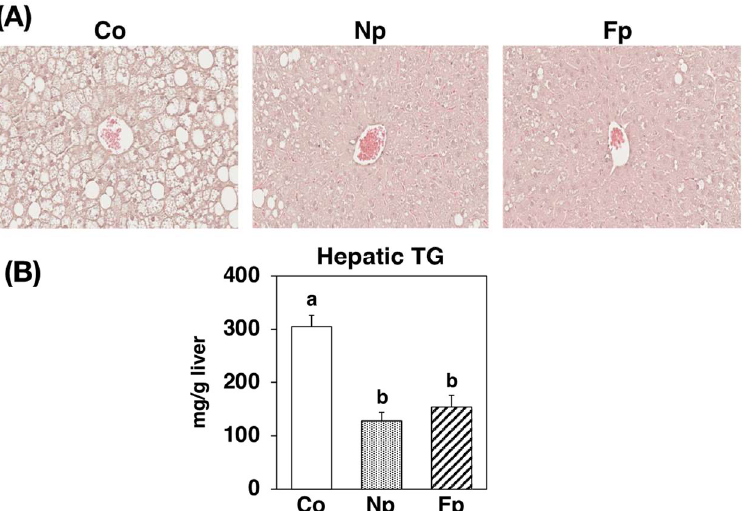
Figure 3. Liver histology and triglyceride levels in db / db mice fed a basal diet (Co group), 10% NP- supplemented diet (Np group), or 10% FNP-supplemented diet (Fp group) for 4 weeks. ( A ) Hema- toxylin and eosin staining of liver sections from mice representative of each experimental group. ( B ) Values are expressed as the mean ± standard error (n = 5–6). ab Different letters denote significant differences ( p < 0.05) among the 3 groups. TG: triglyceride.